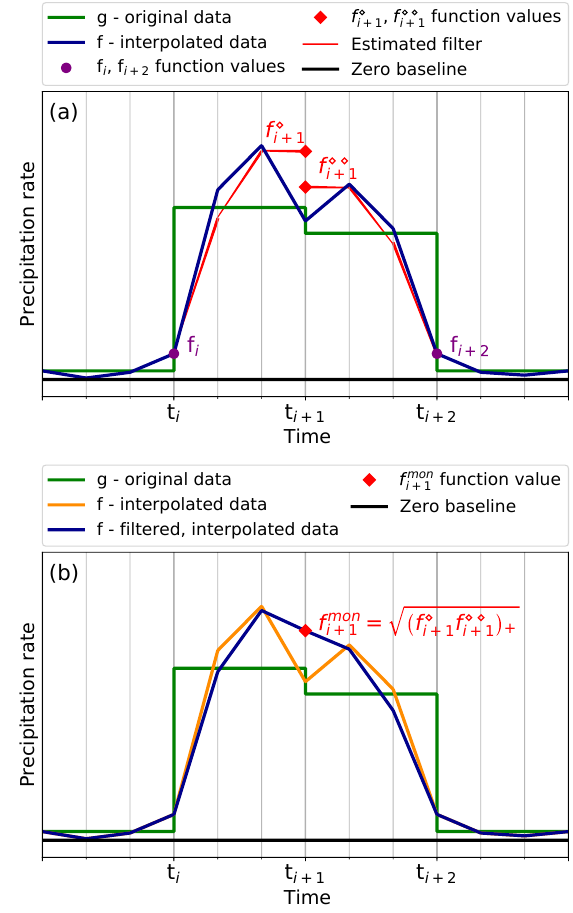
Figure 8. Illustration of the monotonicity filter construction. The original precipitation rate g is shown in green with a 3-hourly res- olution. A zero baseline is shown in black. (a) The interpolated se- ries f from IA0, using the new sub-grid with 1-hourly resolution, is given in dark blue. First, the function value f i + 1 is split in f (cid:5) and i + 1 f (cid:5)(cid:5) shown as red squares. Other function values are recomputed i + 1 as shown with the red line where f i and f i + 2 remain unchanged as shown with purple circles. (b) Second, the function value f i + 1 is substituted by the new function value f mon as marked with a red i + 1 square. The unfiltered graph f derived by IA0 is shown in orange here, while the filtered graph resulting after recomputation of the neighbouring values is shown in dark